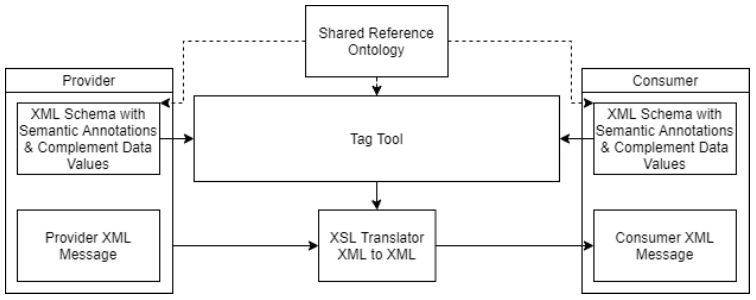
Figure 3. System